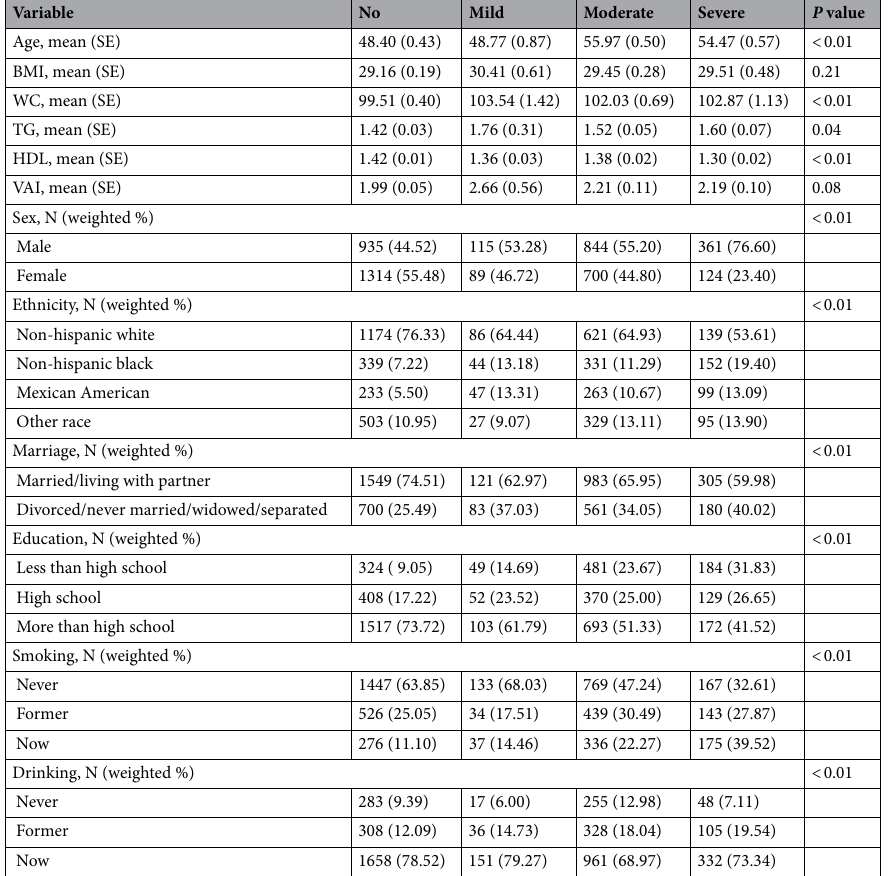
Table 1. Demographic and clinical characteristics of study participants (n = 4482). BMI body mass index, WC waist circumference, TG triglycerides, VAI visceral adiposity index, HDL high-density lipoprotein.